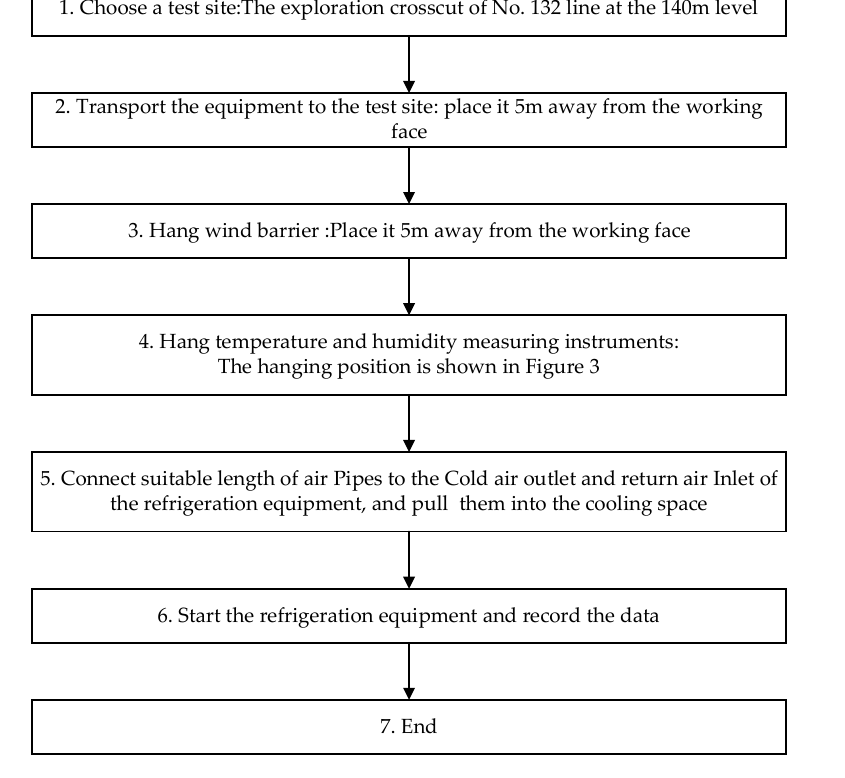
Figure 4. Layout of the test site.